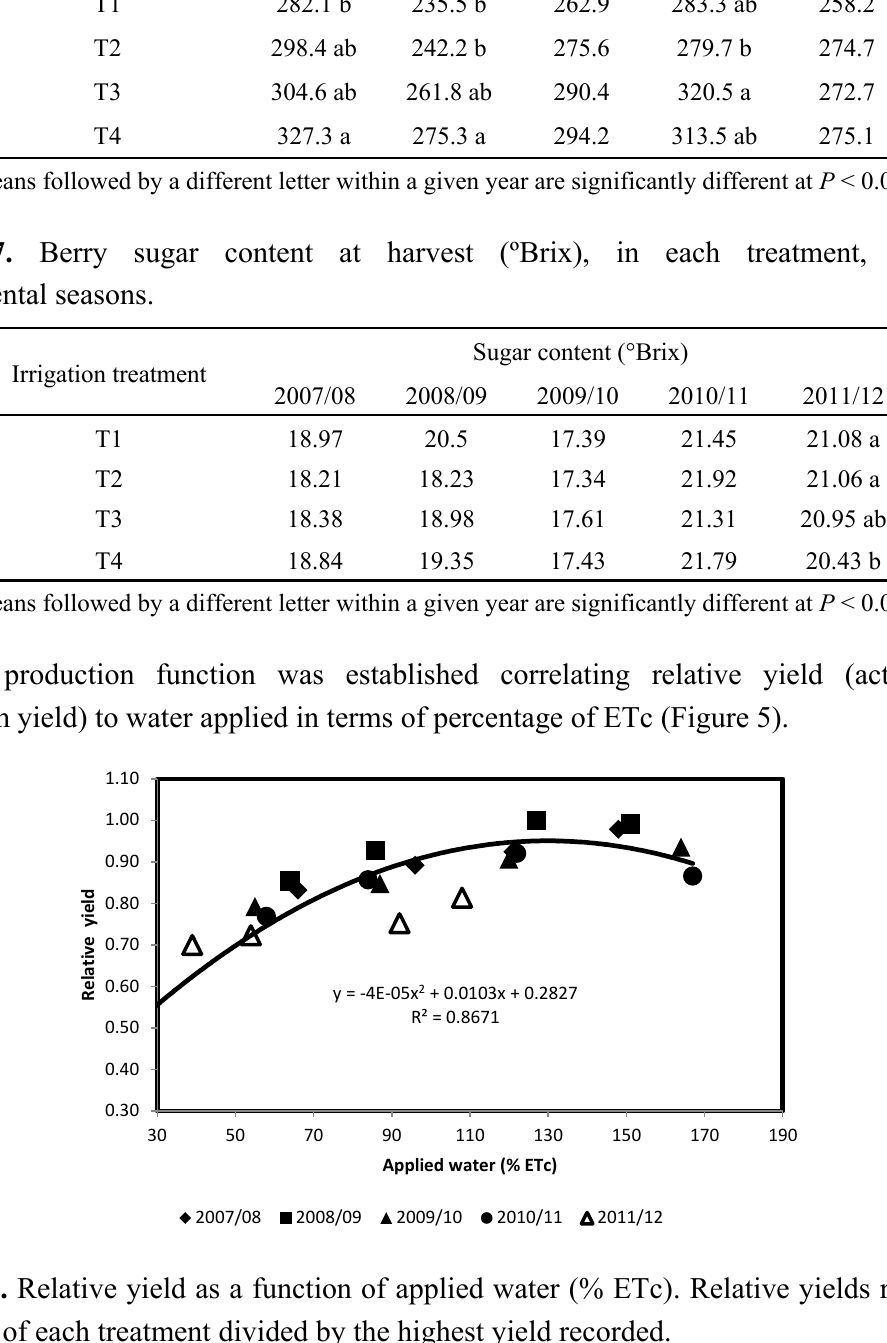
Figure 5. Relative yield as a function of applied water (% ETc). Relative yields represent the yield of each treatment divided by the highest yield